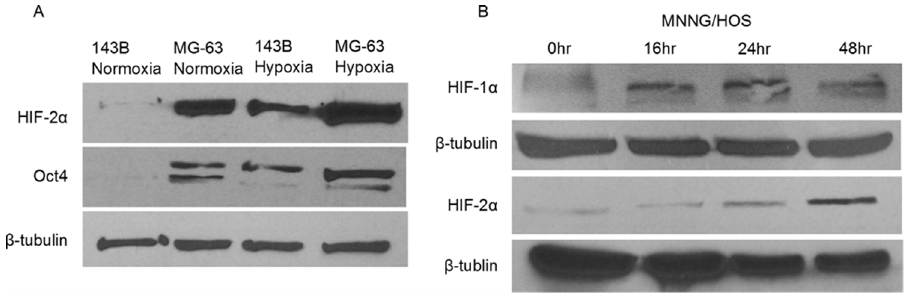
Figure 1. HIFs are present and active in human OS cells. A, 143B and MG-63 human OS cells showed increases in HIF-2 a protein expression by western blot when cultured for 72 hour under hypoxic conditions (0.5% O 2 ). The HIF-2 a downstream target, Oct4, was also increased, indicating HIF signaling activity. b -tubulin was the loading control. B, MNNG/HOS human OS cells were cultured under hypoxia for up to 48 hour and compared to a normoxia (0 hour) control. Both HIF-1 a and HIF-2 a levels were increased as seen by western blot. b -tubulin was used as a loading control.